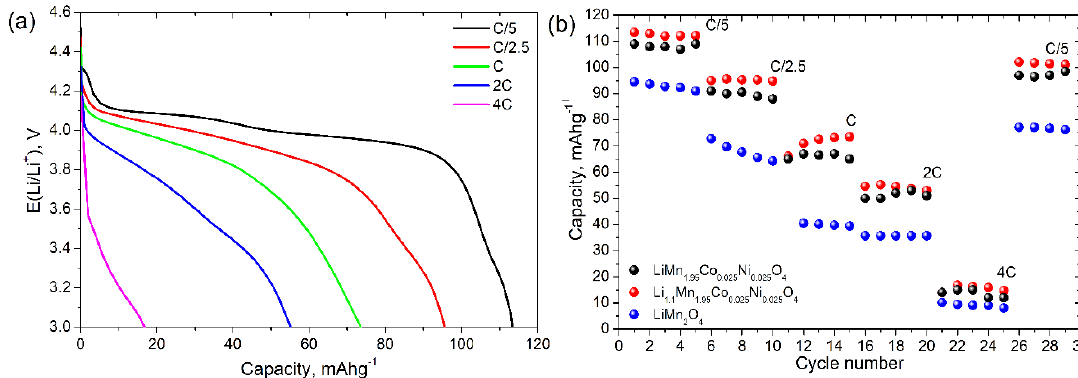
Figure 8. Galvanostatic discharge curves for Li 1.1 Mn 1.95 Co 0.025 Ni 0.025 O 4 at different discharge rates ( a ) and discharge capacity of pristine LiMn 2 O 4 , LiMn 1.95 Co 0.025 Ni 0.025 O 4 and Li 1.1 Mn 1.95 Co 0.025 Ni 0.025 O 4 ( b ). Potential range during cycling is 3–4.6 V.